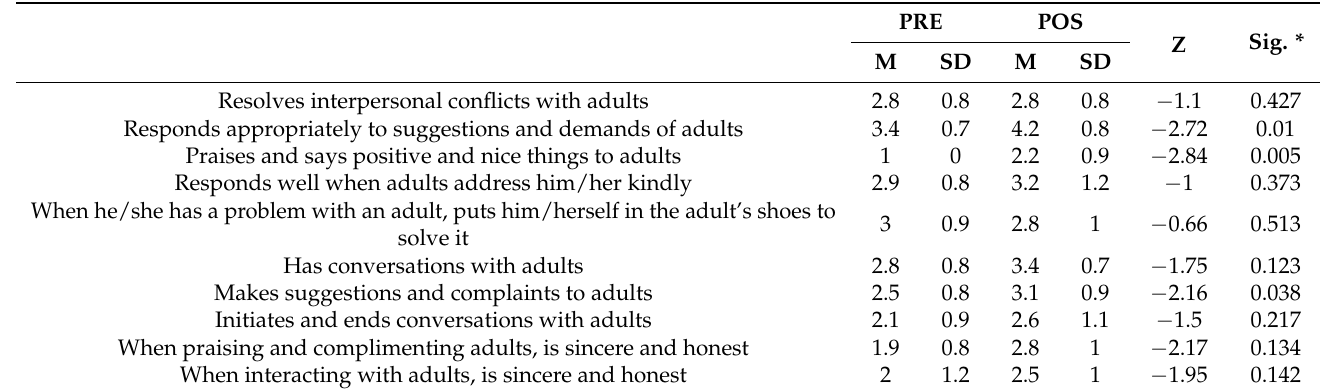
Table 6. Relationship skills with adults.